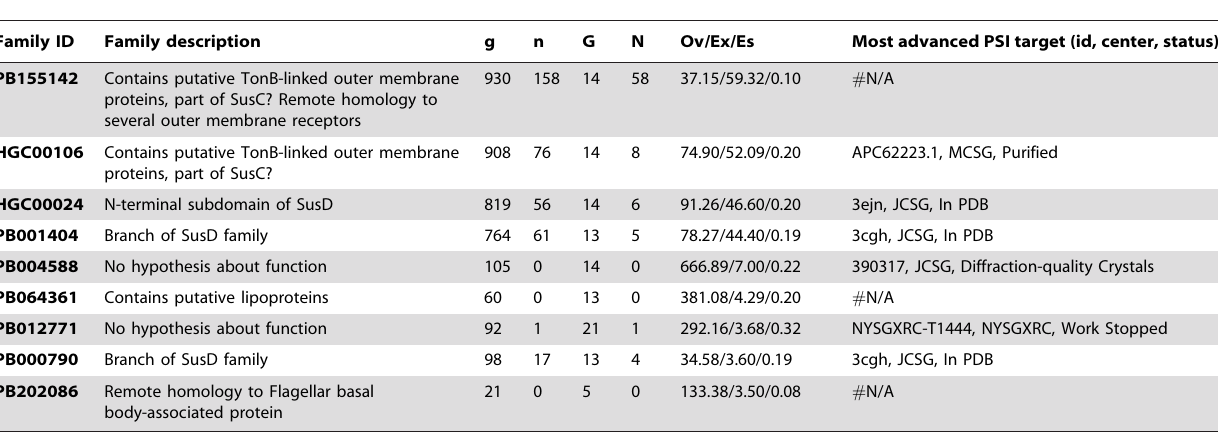
Exact definitions of the Ex category is given in the Methods section. For the details of the Table 5 columns see the legend for Table 4. doi:10.1371/journal.pcbi.1000798.t005 PLoS Computational Biology |